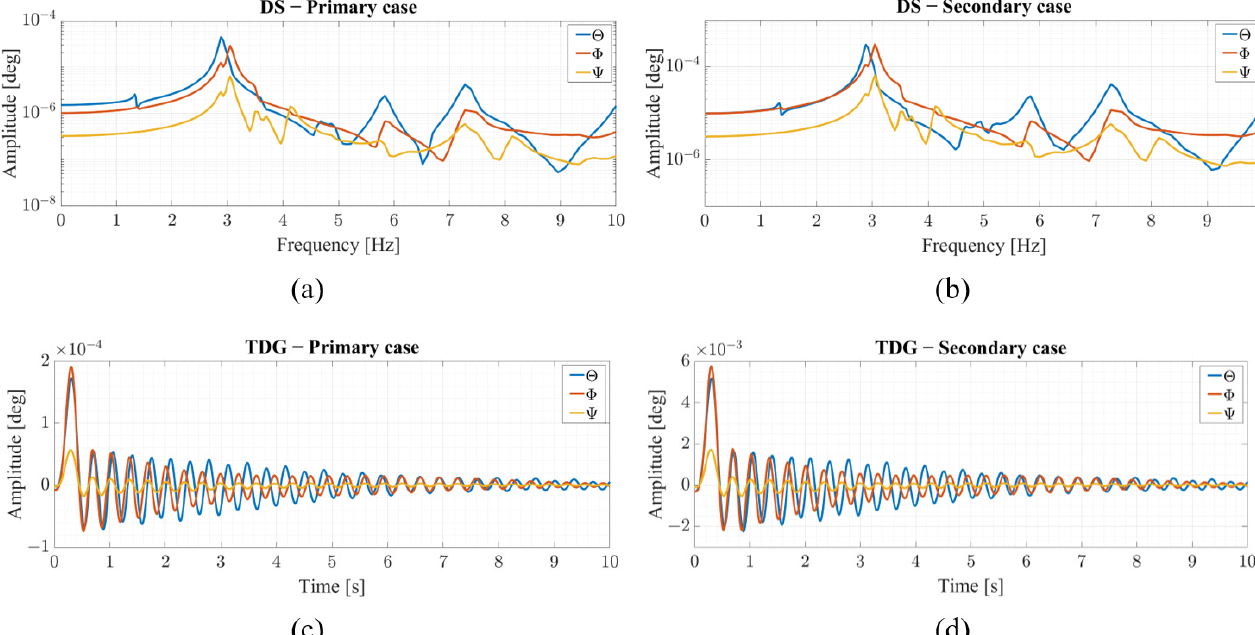
Table 2. Evaluation of the fitness function for the uncontrolled antenna structure.